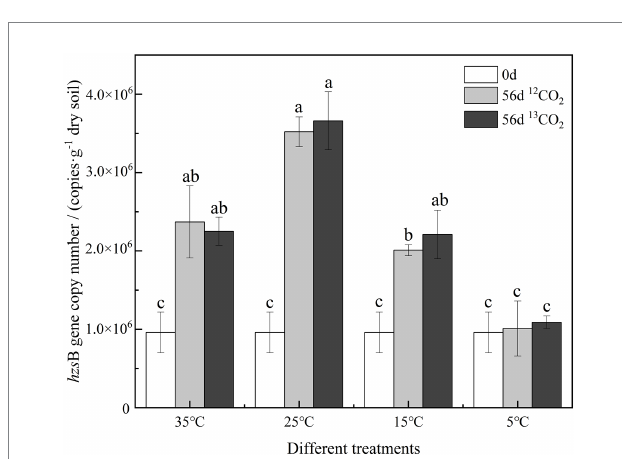
FIGURE 3 The copy number of hzs B genes of anammox bacteria in different treatments. Different letters mean significantly differences among the treatments ( p ≤ 0.05, n =